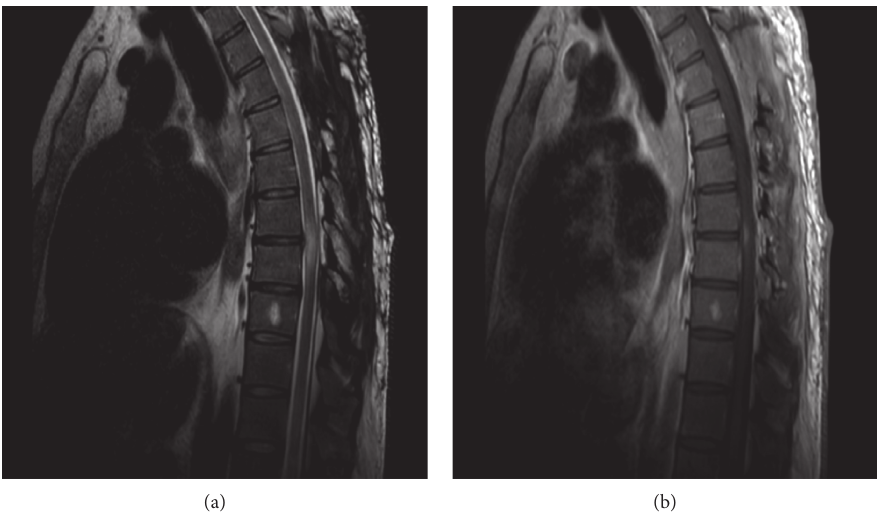
Figure 6: (a) Sagittal T2 MRI of whole spine after 2 months of treatment with mycophenolate mofetil showing decrease in T2 signal involving T7-T8. (b) Sagittal T1 MRI with gadolinium after 2 months of treatment showing further decrease in extent of enhancing